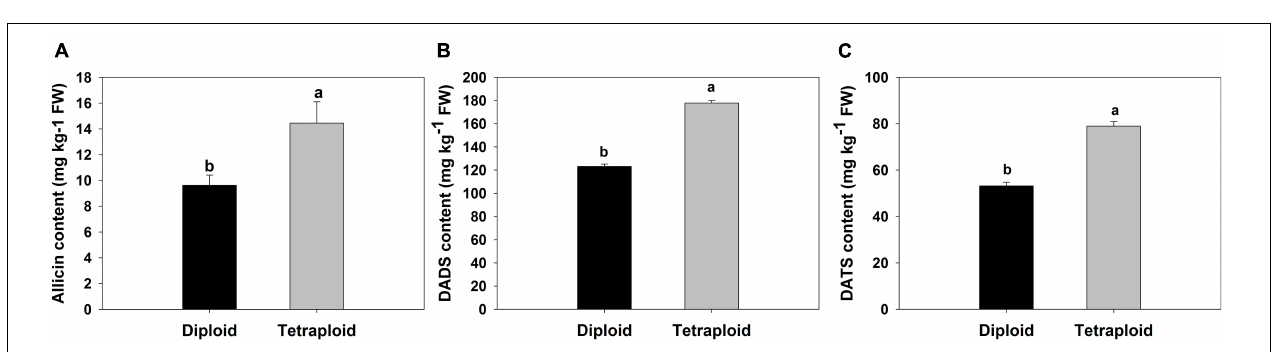
FIGURE 7 | Comparison of sulfur-containing compounds. (A) Allicin, (B) DADS. (C)